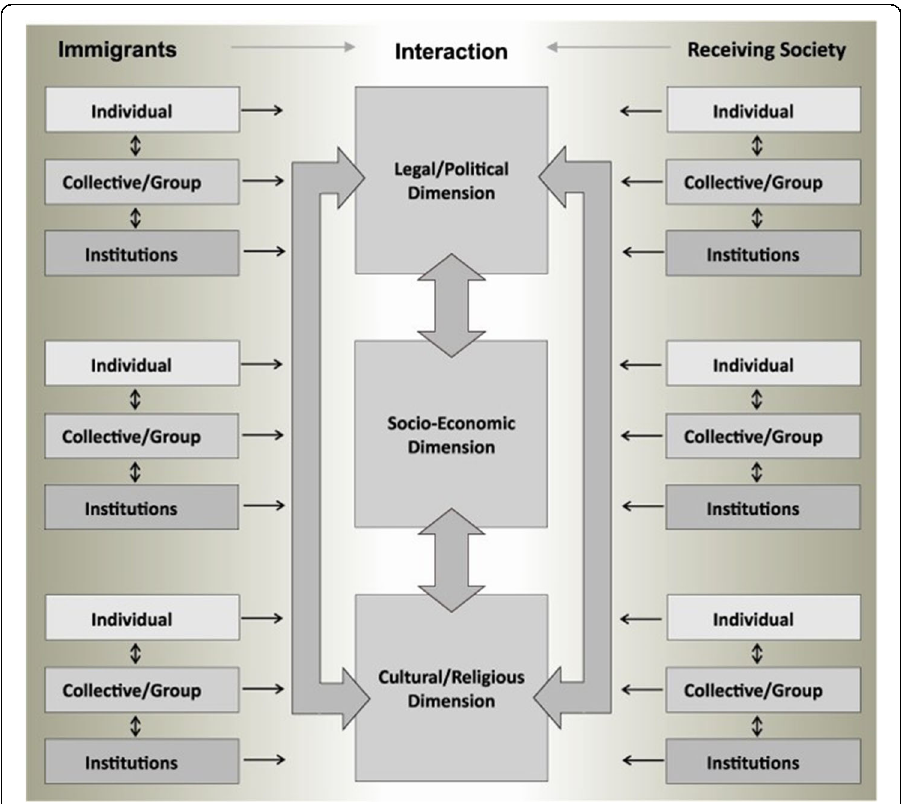
Fig. 1 A heuristic model for the empirical study of integration processes. Source: Penninx & Garcés – Mascareñas (2016, p.